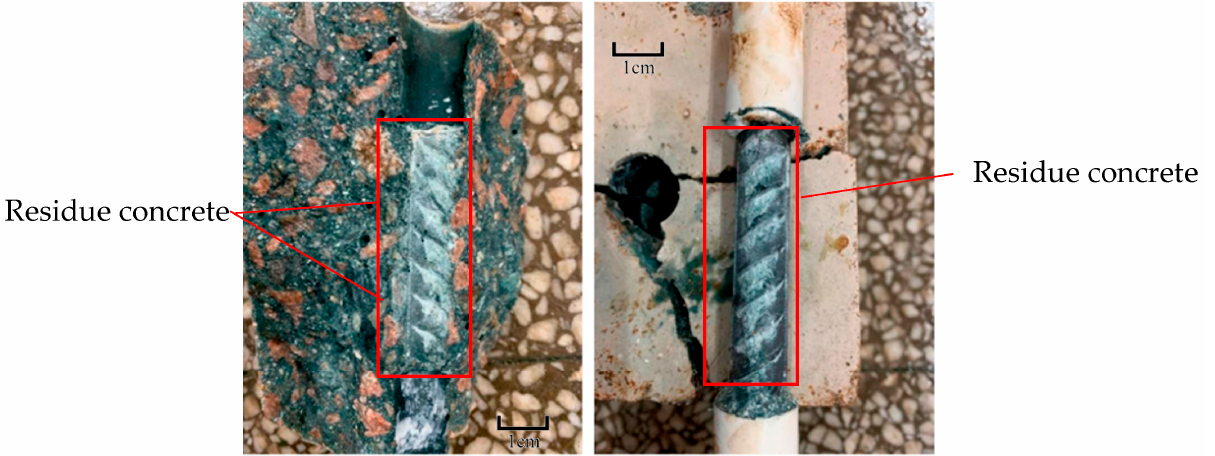
Figure 7. Concrete residue on the bar ribs.